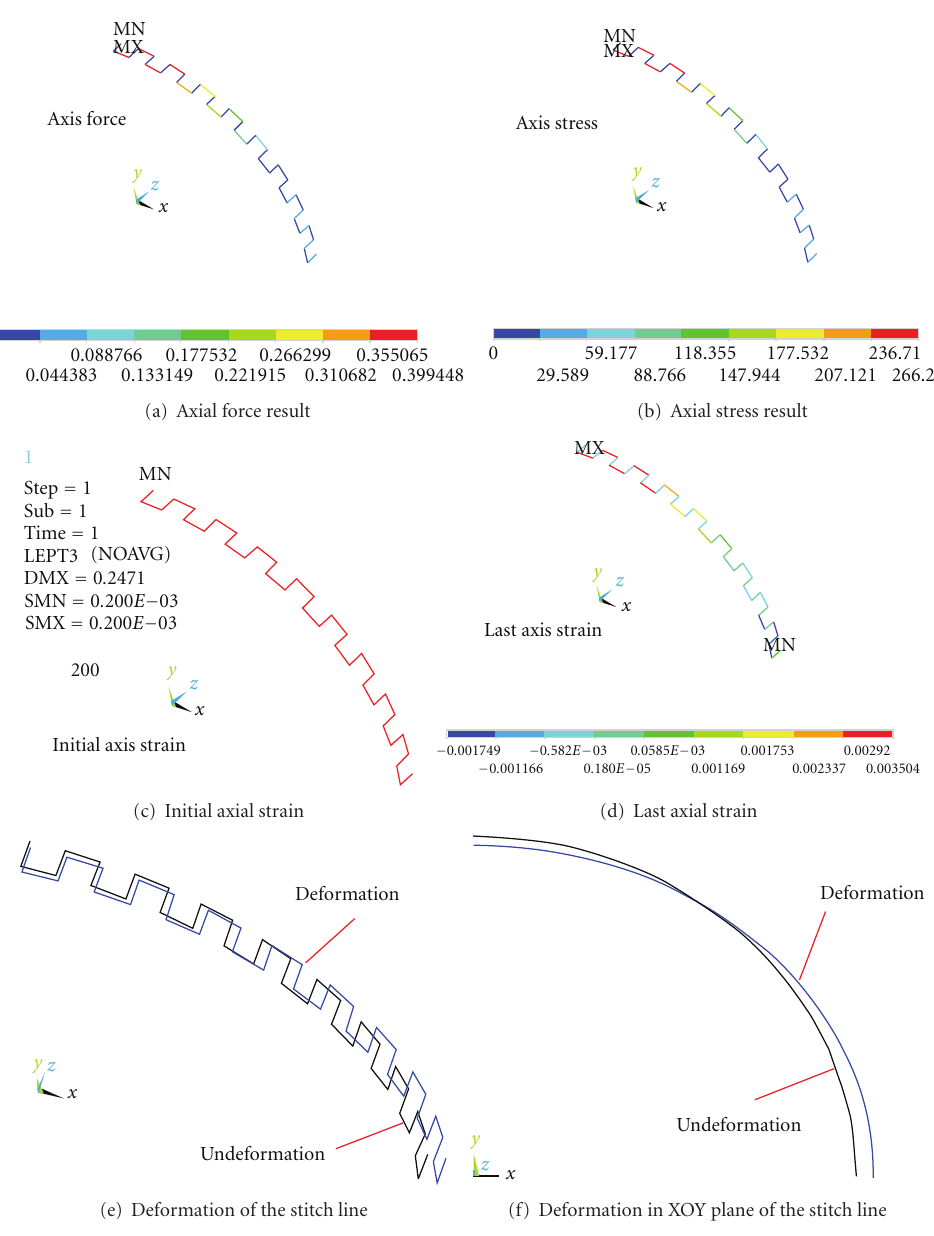
Figure 12: Results of the stitching